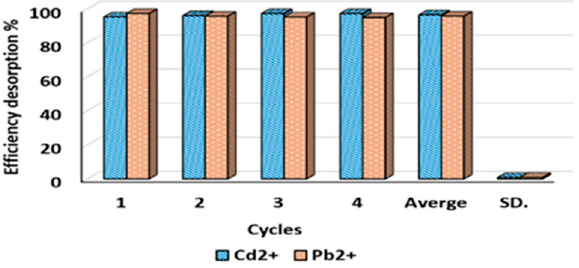
Figure 11. Recovery % of ZnO-NPs composites for Cd 2+ and Pb 2+ during 4 cyclic experiments (C° of 20 mg/L at pH 6.0, respectively).